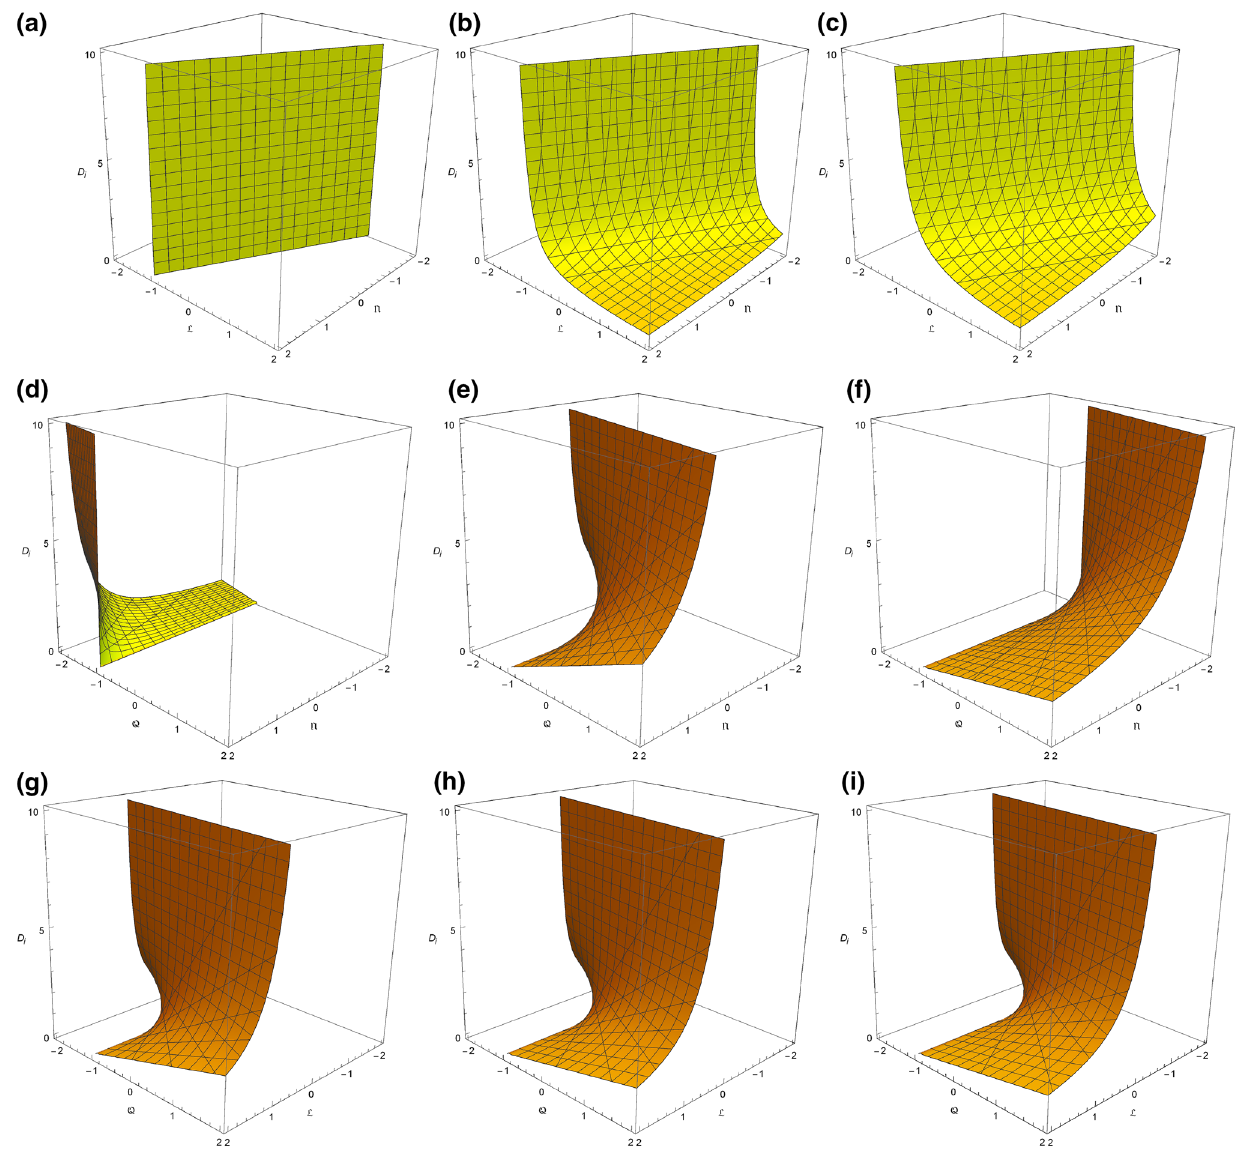
of Q = − 1 , 0 and + 1, respectively. The plots d – f represents the case of L = − 1 , 0 and + 1. The plots g – i represent of N = − 1 , 0 and +